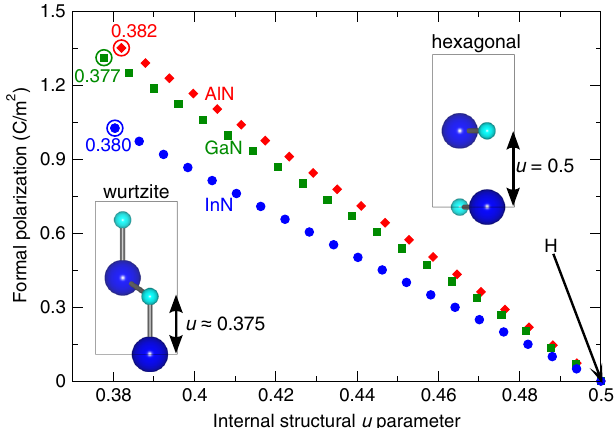
FIG. 1. Formal polarization of InN, GaN, and AlN for struc- tures as a function of the internal structural parameter u , varying between fully relaxed WZ (circled symbols, labeled with the relaxed u value) and H ( u ¼ 0 . 5 ), as shown schematically by ball and stick models, where smaller balls represent N atoms and larger ones represent the cations. All other lattice parameters were fixed at their relaxed WZ